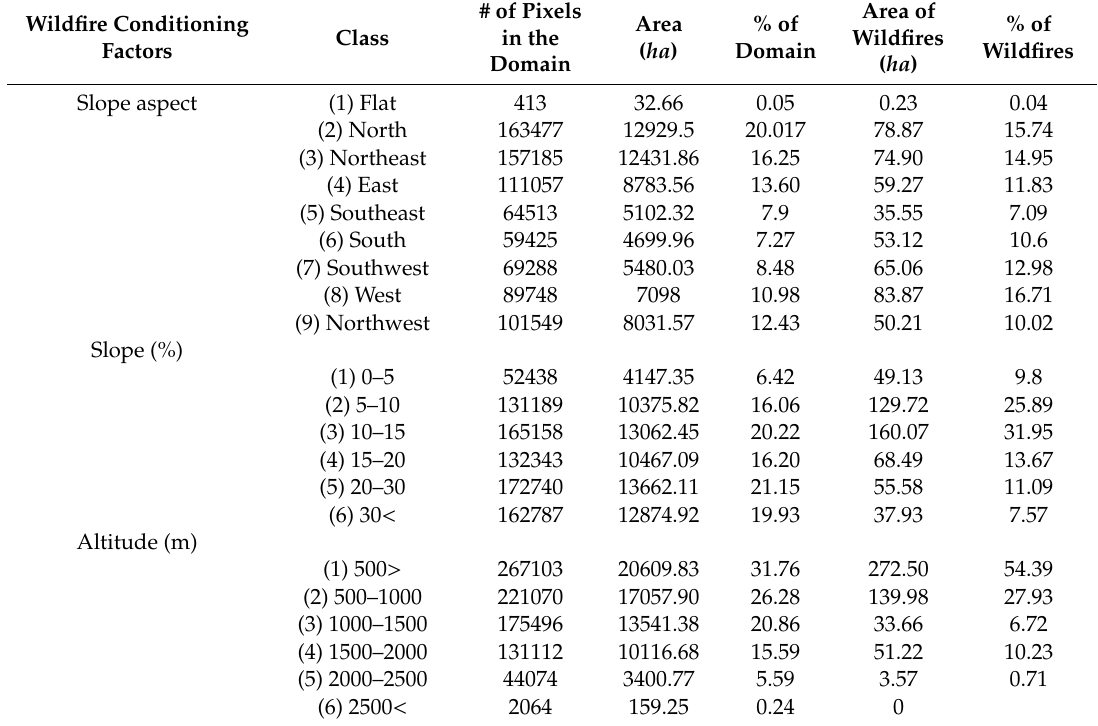
Table 1. The topographic conditioning factors, the area of classes, and percent of the wildfire-a ff ected areas in each